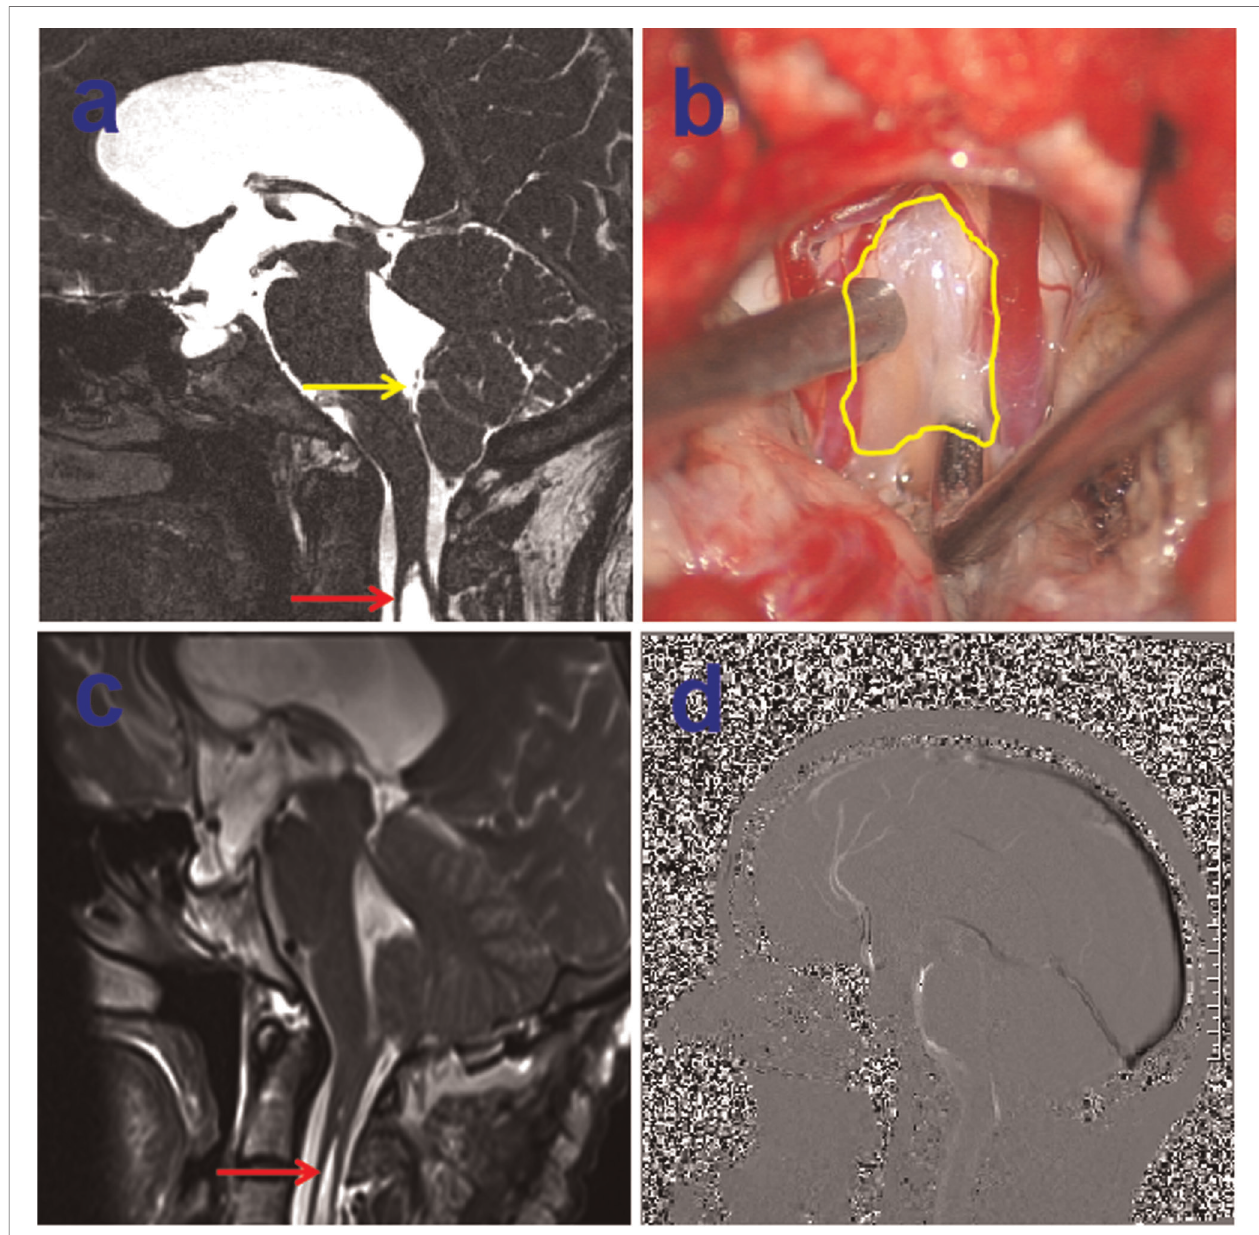
FIGURE 2 | Preoperative 3-dimensional T2-weighted CISS sequence demonstrating arachnoid veil resulting in the cerebrospinal fl uid (CSF) blockage, yellow arrow indicating the arachnoid veil, red arrow showing the syringomyelia ( A ), intraoperative intradural exposure of the craniocervical junction dorsally illustrating an arachnoid veil causing fourth ventricular outlet obstruction, yellow circle showing arachnoid veil ( B ), postoperative MRI showing the remove of arachnoid vei and shrinkage of syringomyelia on red arrow ( C ), postoperative sagittal cine-PC showing the improvement of CSF fl ow ( D